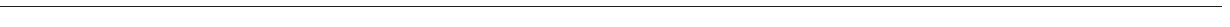
Fig. 1 Eukaryotic-speci fi c segments of eS26 are required to bind Tsr2. a XL-MS reveals crosslinks between ESS2 and N-terminal domain of Tsr2. The crosslinked residues are listed in the Supplementary Table 1. b Phylogenetic analyses for eS26 and Tsr2. ESS1, ESS2 from eS26 and Tsr2 are present only in eukaryotes. c Sequence alignment of yeast S26 compared to the indicated species. 70 d ESSs in eS26 are required to bind Tsr2 in vitro. GST-Tsr2 was immobilized on Glutathione Sepharose before incubation with E. coli lysate containing recombinant WT eS26, eS26 de fi cient in ESS1 and/or ESS2 or archaeal eS26 from Sulfolobus solfataricus . Bound proteins were eluted by SDS sample buffer, separated by SDS-PAGE and visualized by Coomassie Blue staining. L = input (1:10 diluted). e Residues 99 – 109 in eS26-ESS2 are necessary to bind Tsr2 in vitro. GST-Tsr2 was immobilized on Glutathione Sepharose before incubation with an E. coli lysate containing recombinant WT eS26 or eS26 with variant truncations in C-terminal ESS2. Samples were analyzed as